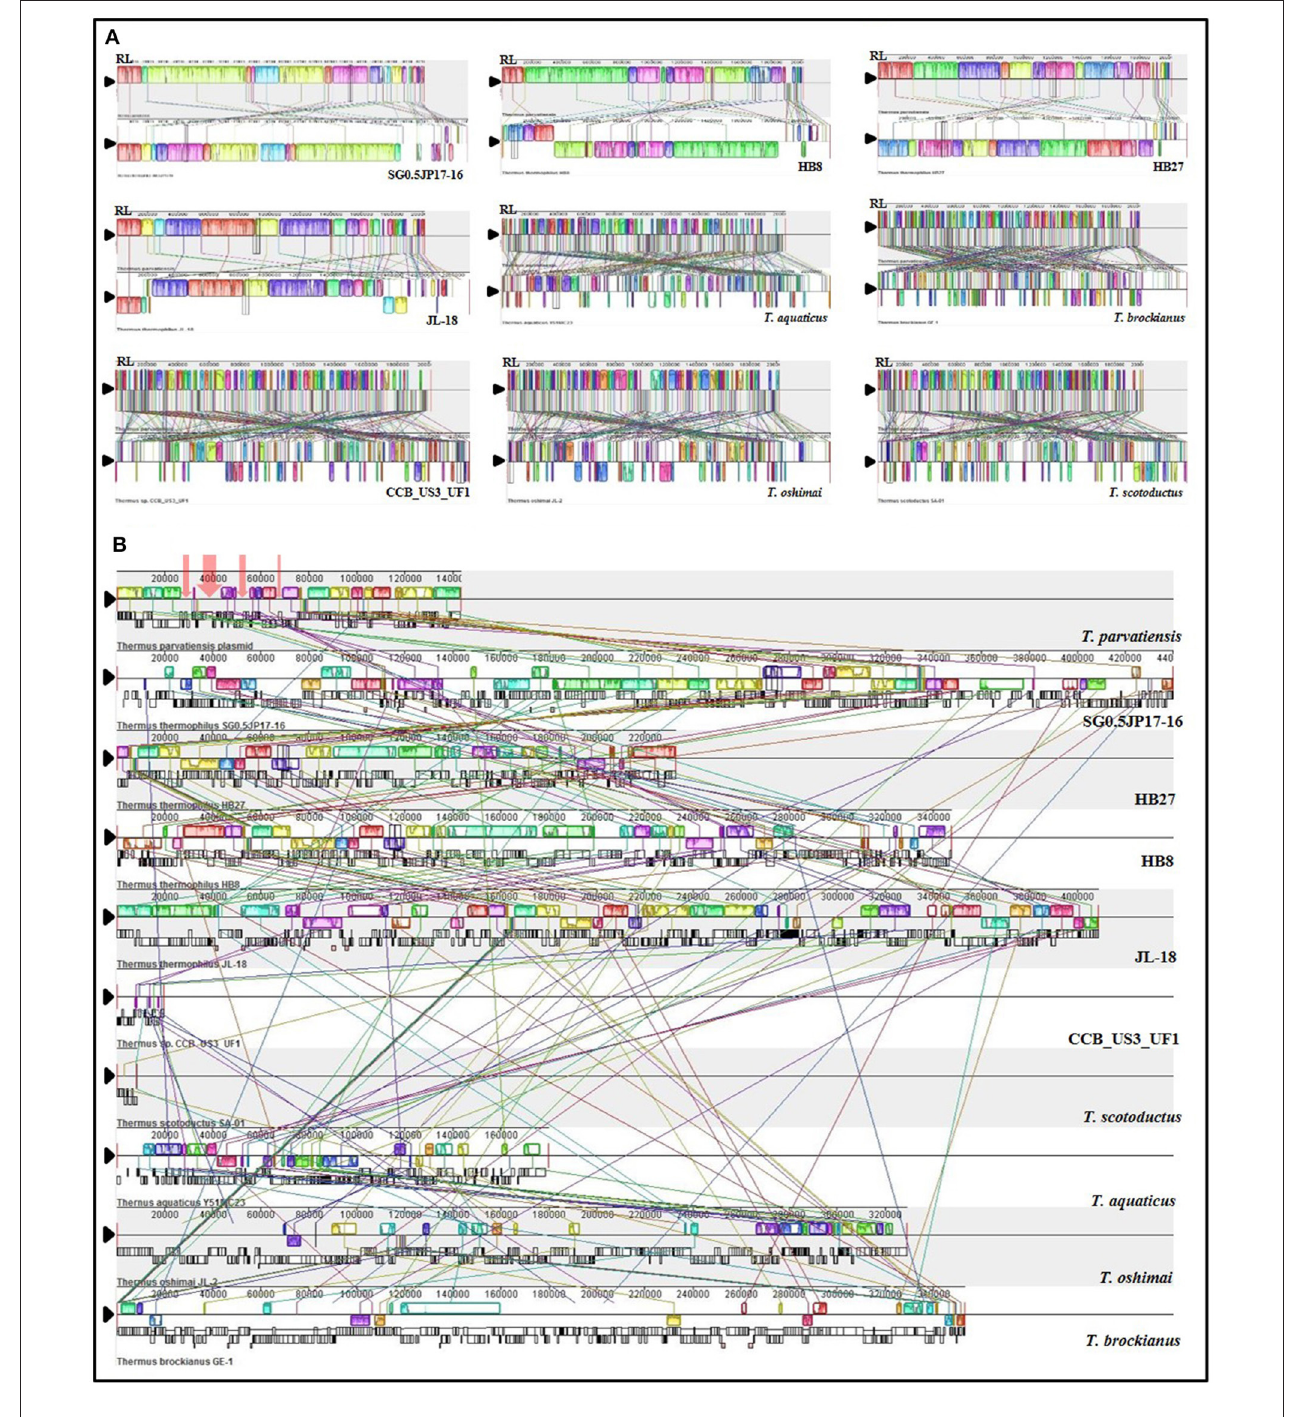
FIGURE 3 | Organizational (synteny) comparisons of T. parvatiensis with nine representatives of Thermus . Only members with complete genomes have been considered for this analysis. Synteny maps showing (A) comparison of the chromosome of T. parvatiensis against the chromosomes of other genomes; and (B) comparison of plasmid pTP143 against plasmid sequences (concatenated wherever number of plasmids > 1) of other Thermus members. Boxes of different colors represent locally collinear blocks (LCBs) (or locally conserved regions) connected via lines of the same color to their corresponding positions on other genomes. For each genome, the LCBs above and below the reference line (indicated by black triangle) denote the orientation of the LCBs with respect to the reference sequence (LCBs below the black reference line denote inversions). Black lines (in B ) below LCBs represent the position of coding sequences. Red arrows on plasmid pTP143 (in B ) mark the regions that could not be mapped on other Thermus